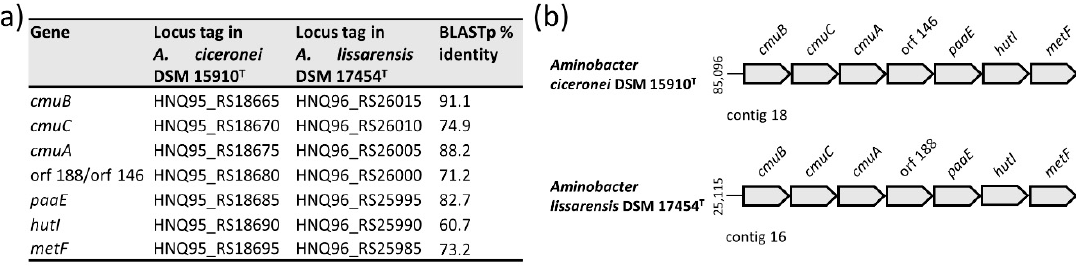
Figure 8. ( a ) Summary results of BLASTp comparison of translated nucleotide sequences from methyl halide degradation genes from A. lissarensis DSM 17454 T and A. ciceronei DSM 15910 T ; ( b ) Physical organization of methyl halide degradation genes in A. lissarensis DSM 17454 T and A. ciceronei DSM 15910 T ; cmuA , methyltransferase I; cmuB , methyltransferase II; metF , 5,10-methylenetetrahydrofolate reductase; cmuC , paaE and hutI are genes of uncertain function. Coordinates are numbered according to the first base of each contig. The map is not to scale.